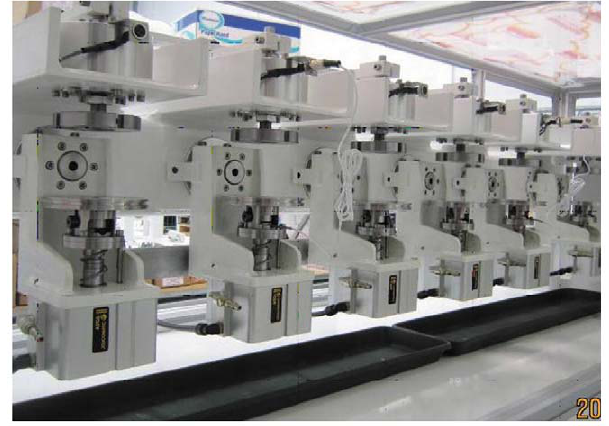
Figure 2. Six-Station Prosim 2 Hip Simulator (Simsol, Stock- port, UK).